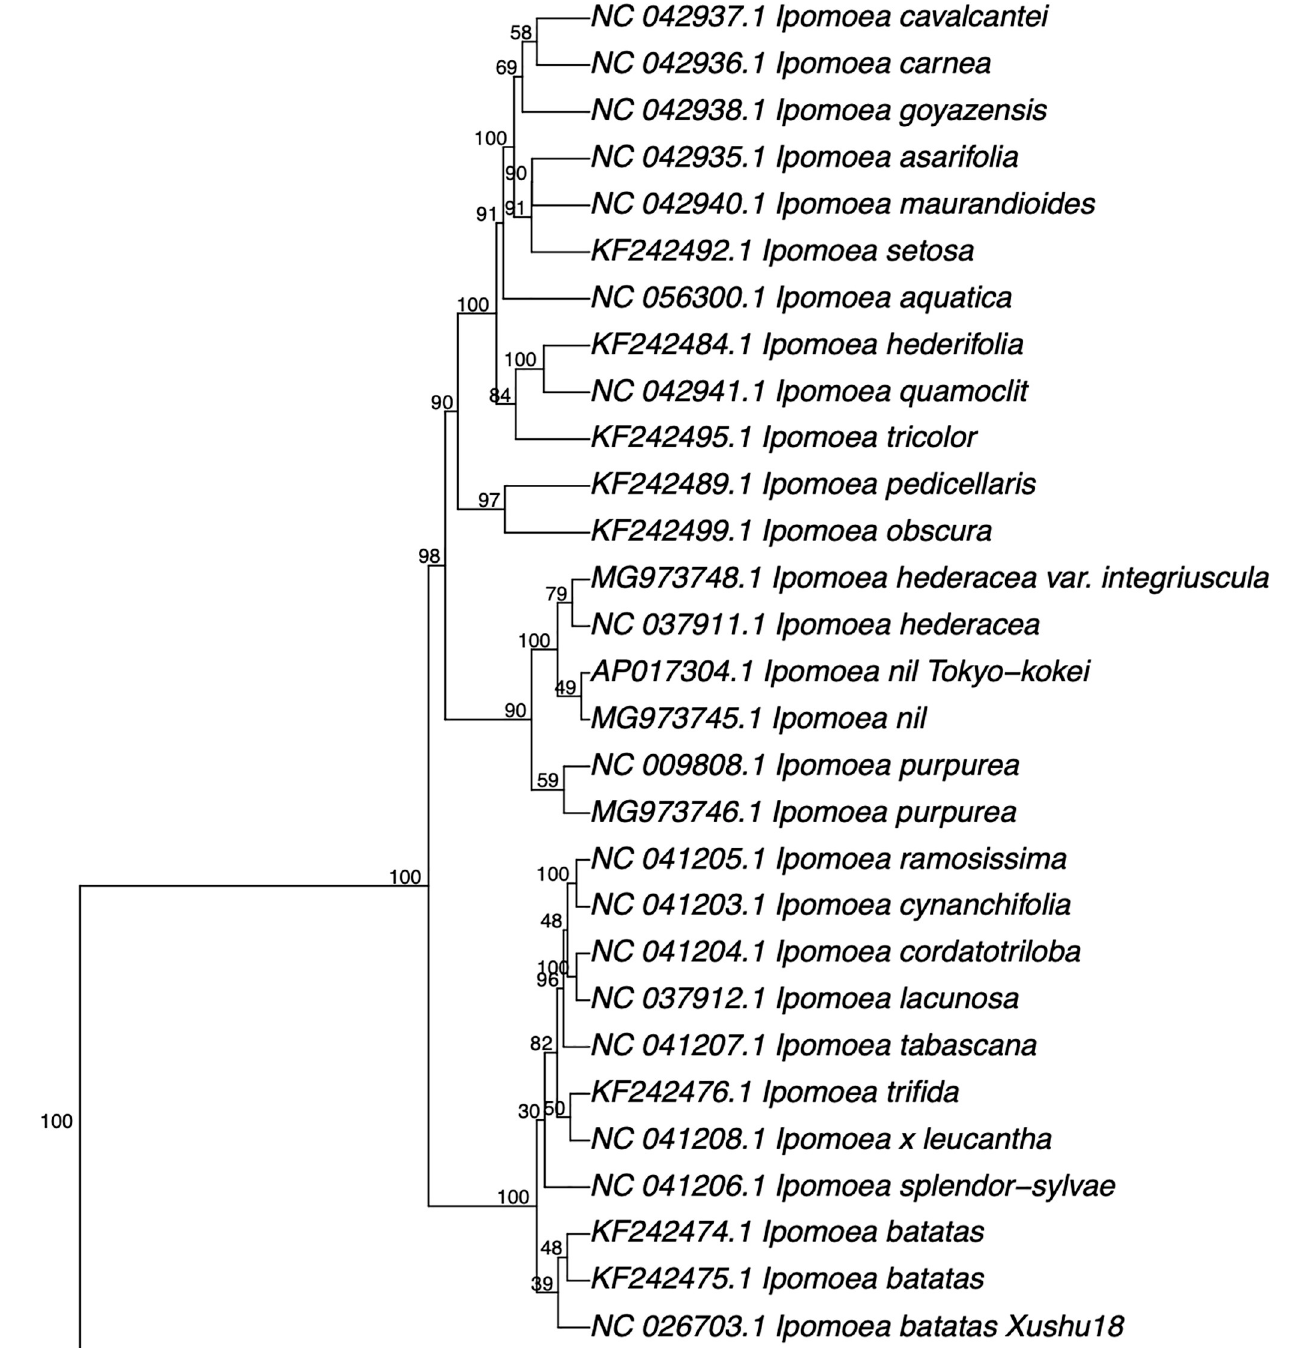
Fig 5. Phylogenetic trees of Ipomoea species based on their chloroplast genomes. The numbers at the nodes indicate the percentage occurrences among 1,000 bootstrap values. Separated groups of species and serotypes are highlighted.